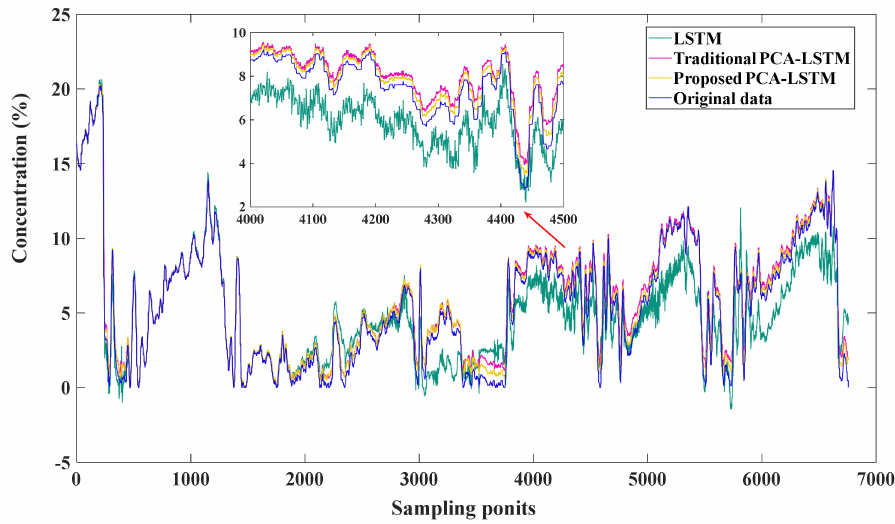
Figure 13. The testing result of comparative study.